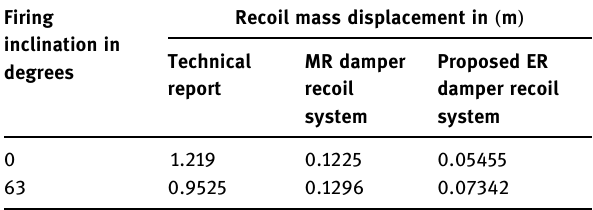
Table 3: Comparison of recoil mass displacement Firing inclination